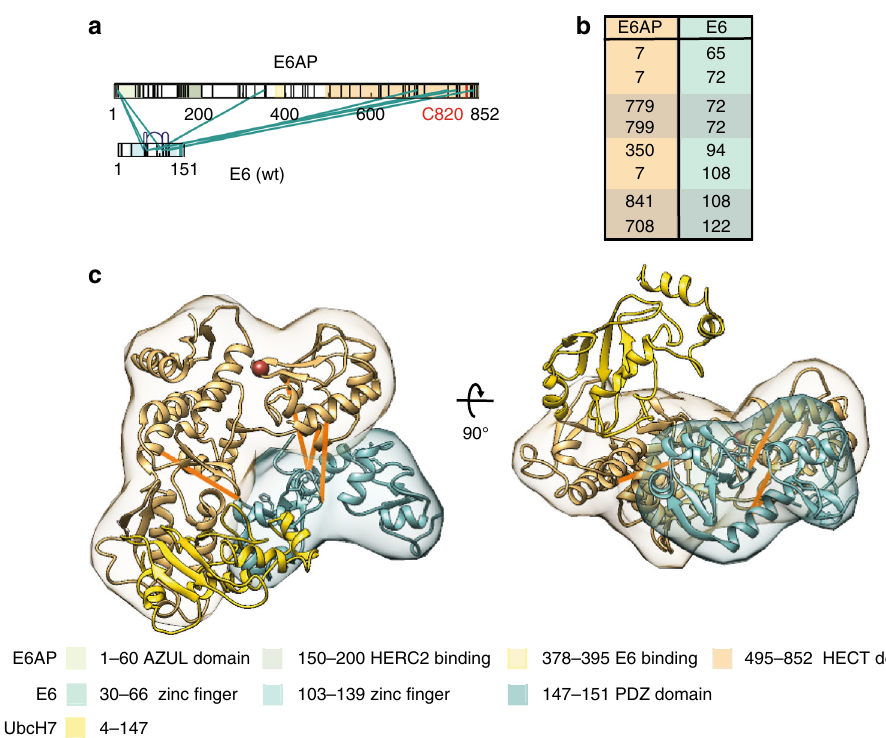
Fig. 3 E6 contacts the HECT domain of E6AP. a Shown are the identi fi ed interlinks between E6AP and E6. Lysine residues and regions of known functions within E6AP and E6 are color-coded as in Fig. 1. b List with identi fi ed interlinks between E6AP and E6. Numbering is according to human E6AP isoform 1 33 . Links which can be mapped to existing PDB structures (4XR8; 1C4Z) are highlighted. c Structural model of the binding interface between the HECT domain of E6AP and E6. The localization densities of the HECT domain of E6AP (residues 495 – 846) and E6 (residues 1 – 151) are shown in sand yellow and light green, respectively, with a single representative ribbon structure embedded. For clarity, UbcH7, a cognate E2 of E6AP, was also added and is shown in yellow (PDB: 1C4Z). Detected interlinks between E6 and E6AP that map to PDB structures 4XR8 and 1C4Z, respectively, are highlighted in orange. The catalytic cysteine on position C820 in the HECT domain of E6AP is shown as a red ball. The model is shown from the top (left) and from a side view